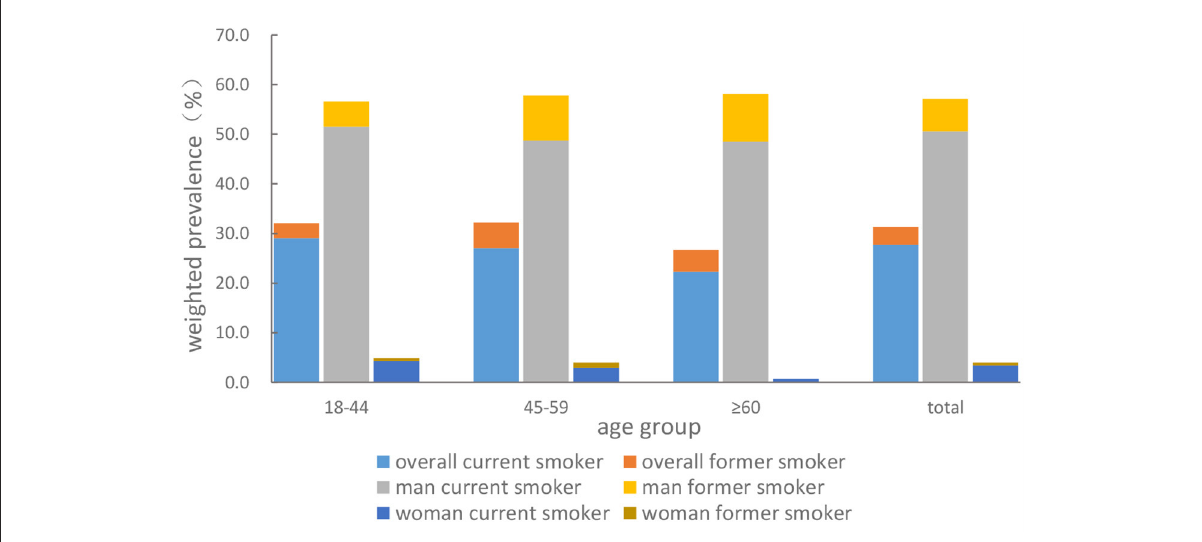
FIGURE1 Weighted smoking prevalence of ever-smoking, currently smoking, and former smoking among Dulong people aged 18 and above in 2020.